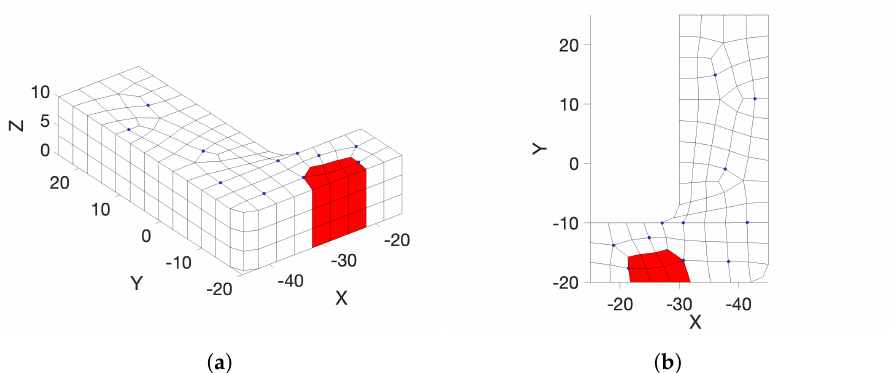
Figure 14. Damaged region (red) and location of the 22 sensors (nodes highlighted in blue). ( a ) Top view; ( b ) bottom view.